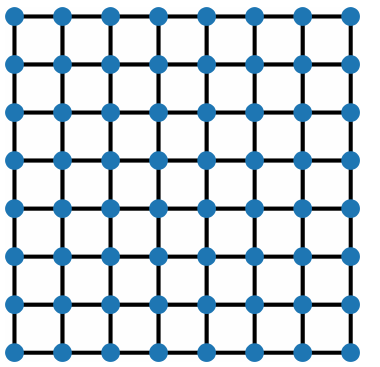
Figure 4. A square wind power plant that has been discretized with a square grid for wind turbine number and layout